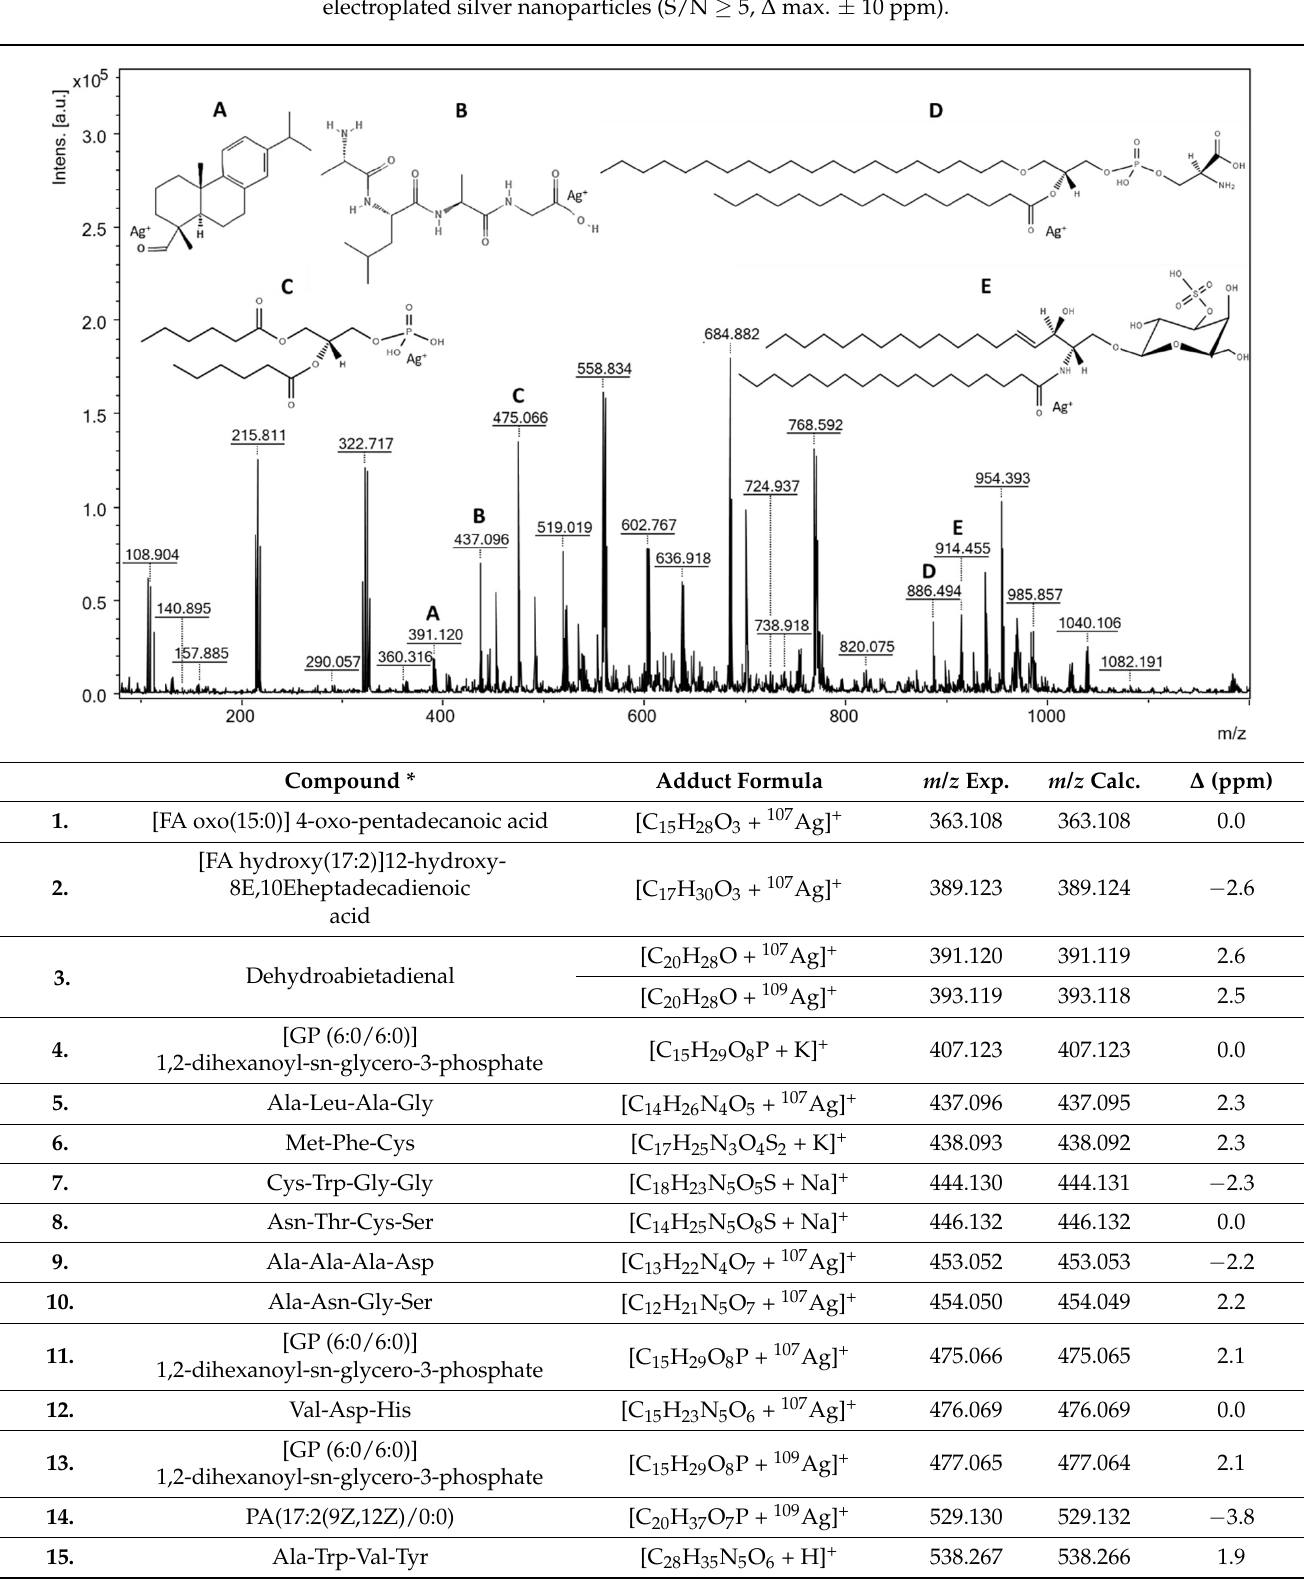
Table 4. SALDI mass spectrum of Lactococcus lactis lipid extract made on an AgNLET plate with